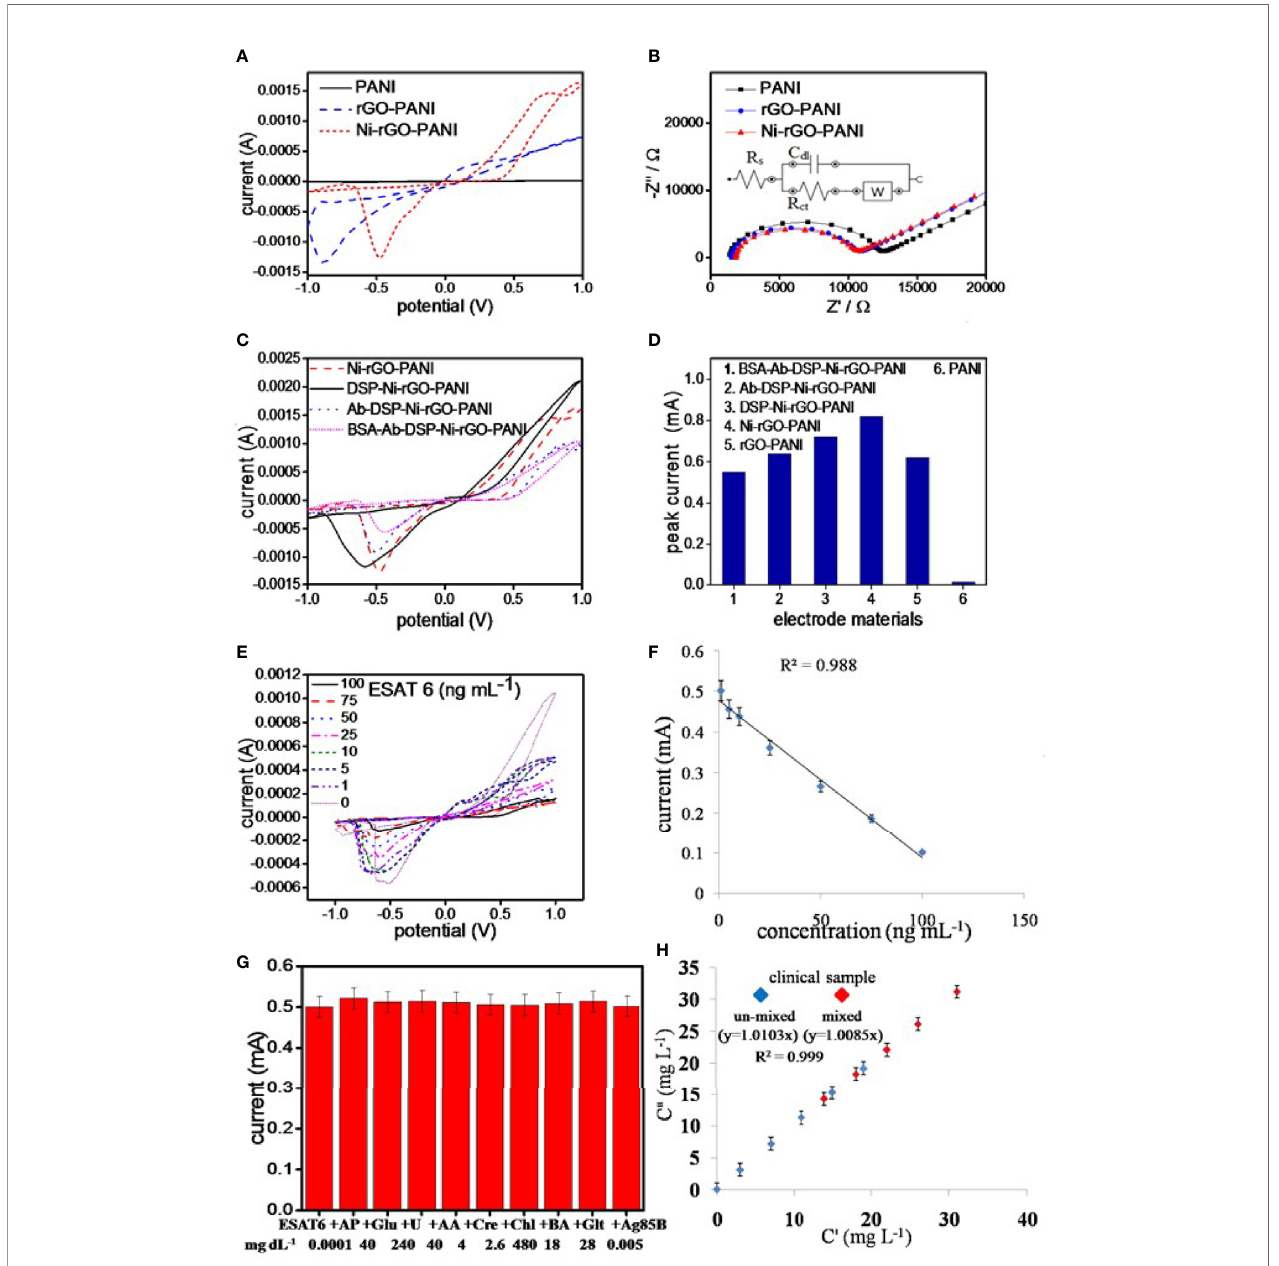
FIGURE 4 | (A) CV and (B) EIS analysis of the electrode materials, (C) CV analysis of the surface modi fi ed electrodes, (D) peak currents in the surface modi fi ed materials, (E) CV analysis of BSA-Ab-DSP-Ni-rGO-PANI at different ESAT-6 concentration, (F) calibration plot for the prepared TB sensor, (G) selectivity data measured at LOD, and (H) measurements in the synthetic clinical samples (C ” ) vs . prepared ESAT-6 (C ’ ) in the clinical